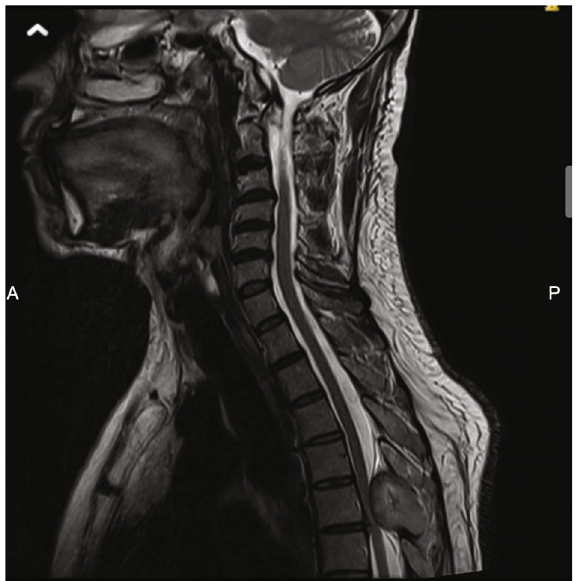
Figure 1: T2-weighted sagittal MR of the neck showing the spinal lesion at the level of